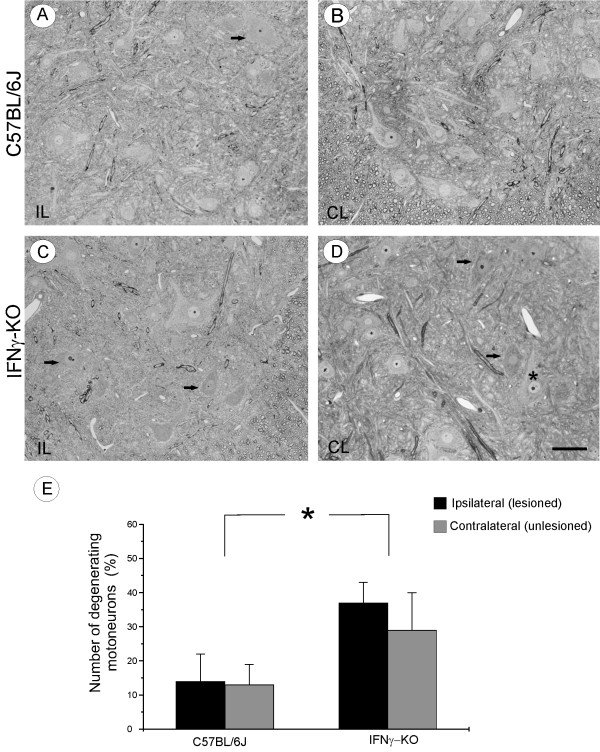
Light photomicrographs of spinal cord ventral horn of C57BL/6J and IFNγ-KO mice from semithin sections stained with toluidine blue. (A) Ipsilateral (lesioned) side and (B) contralateral (unlesioned) side of C57BL/6J mice. (C) IFNγ-KO ipsilateral side shows some motoneurons with hyperchromatic changes in the cytoplasm and nuclei (arrows). (D) IFNγ-KO contralateral side with pyknotic neurons found among at normal neurons (asterisk). (E) The number of degenerated motoneurons in axomized animals. Scale bar: 50 μm